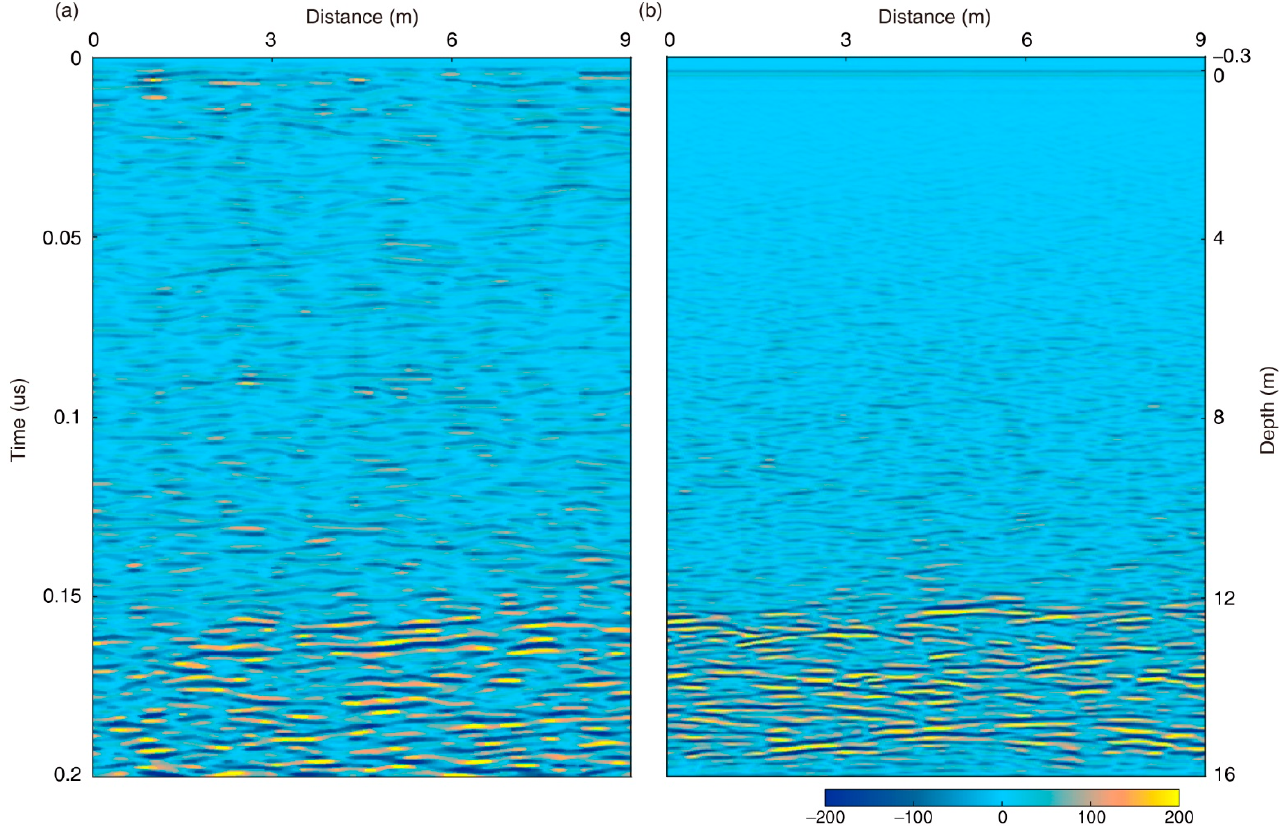
Figure 15. ( a ) Yutu-2 radar profile. ( b ) Numerical simulation LPR profile with correlation distance of 10 cm and RMS perturbation of 3%.